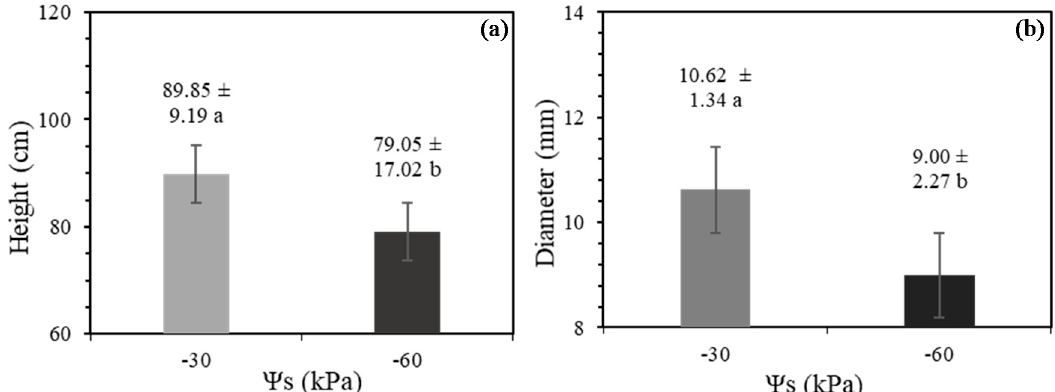
Figure 1. Plant height ( a ) and stem diameter ( b ) of tomatoes under potential water in the soil ( Ψ s) of − 30 and − 60 KPa at 48 DAT. Different letters represent statistically relevant differences at 5% by the F test.